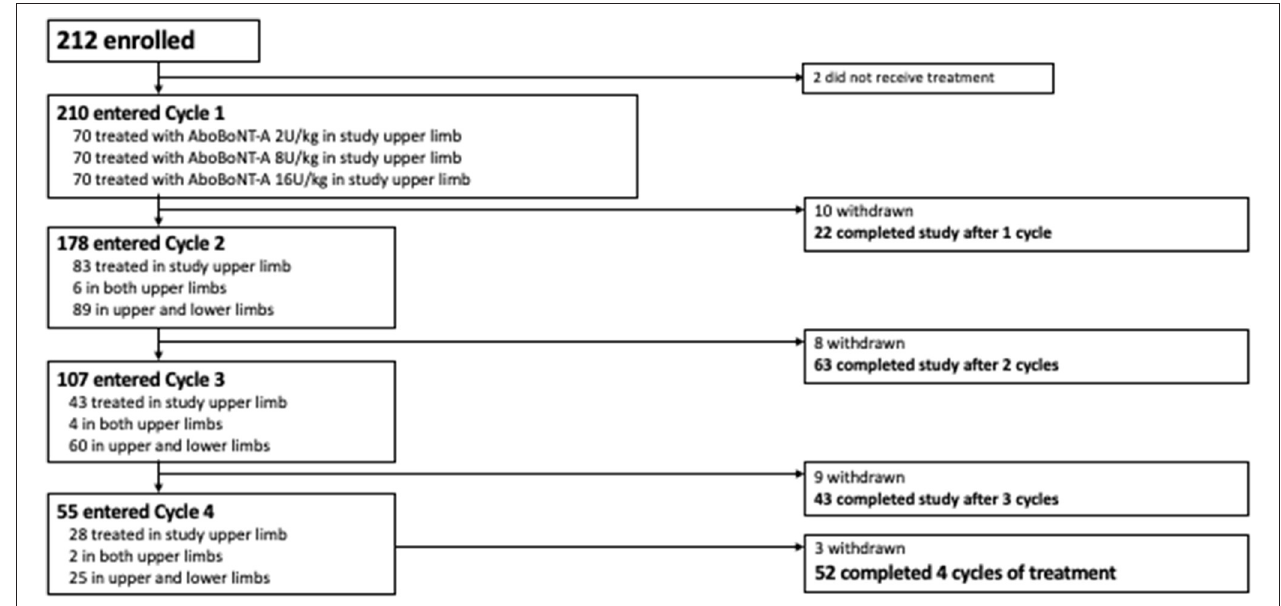
FIGURE 1 | Patient disposition. AboBoNT-A, abobotulinumtoxinA.